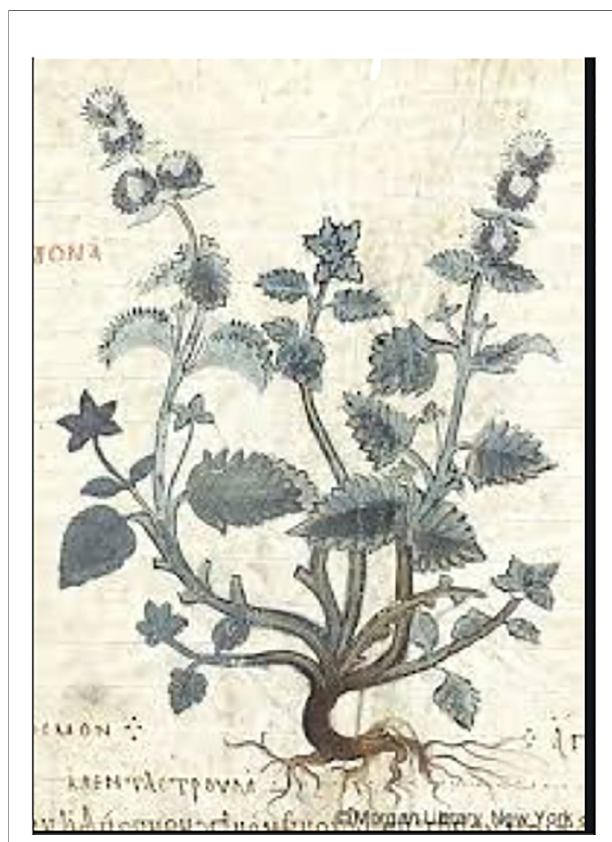
FIGURE 5 | Image of M. aquatica , labeled Eduosmos agrios, is from the Pierpont Morgan recession of Dioscorides De material medica . This book dates to about 1050 CE, and the plants are alphabetically arranged. Morgan Library New York.